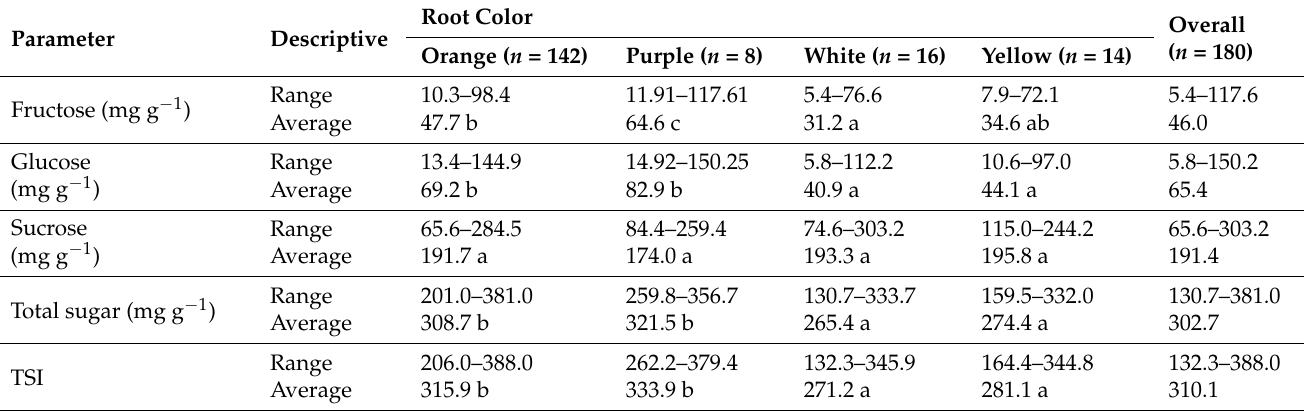
Table 5. Variation in free sugars and total sweetness index (TSI) in carrot genetic resources ( n =